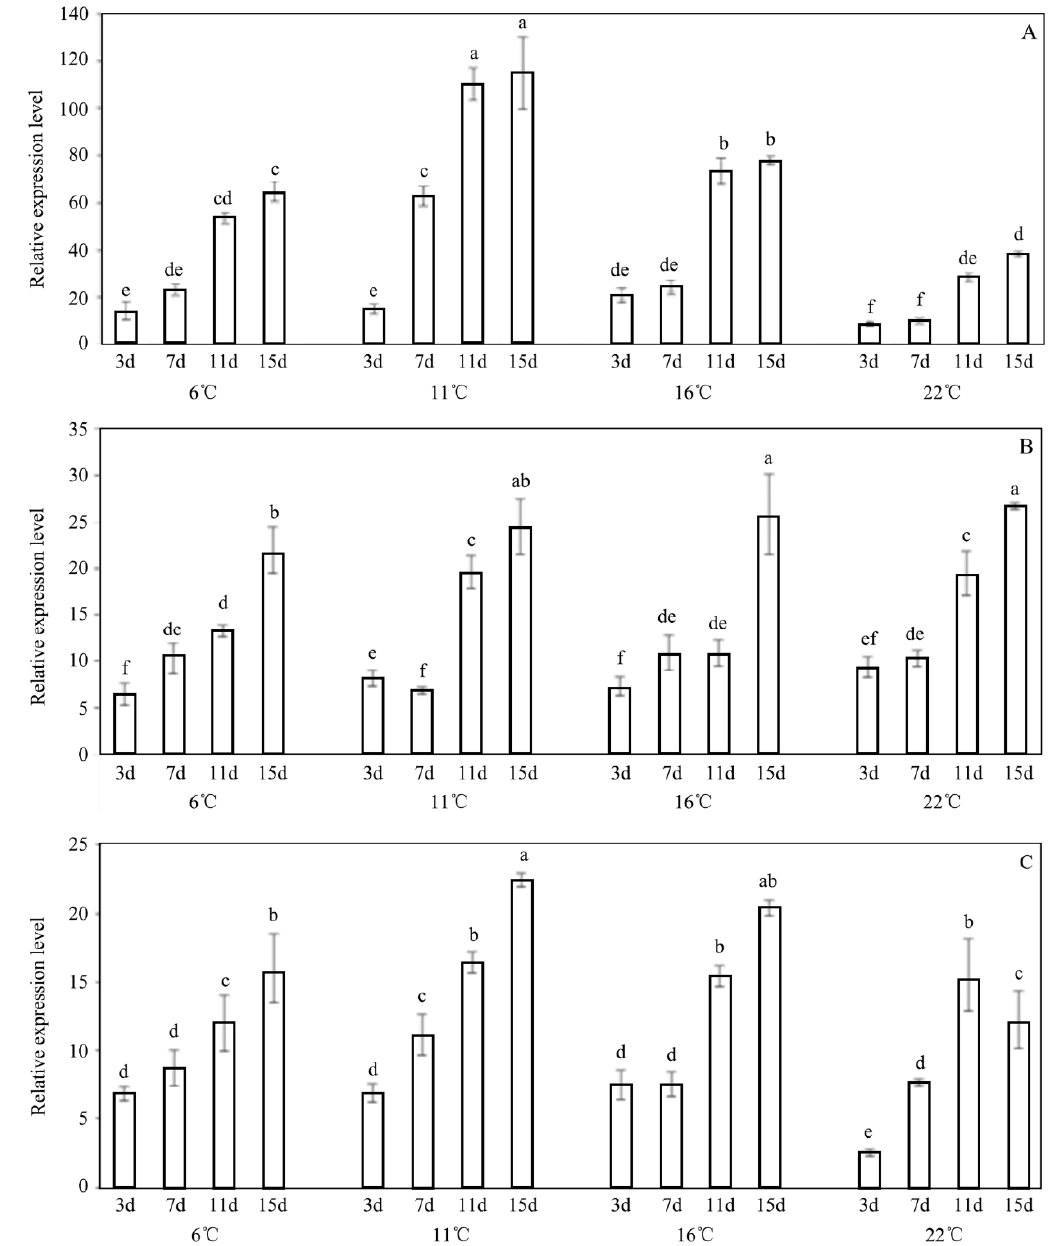
Figure 6. Expression profiles of trehalase genes of E. extimalis after exposure to INA bacteria. ( A ) 0.1 OD; ( B ) 0.2 OD; ( C ) 0.3 OD. Results are shown as the mean ± SD. Letters on the error bars indicate significant differences analyzed using the one-way analysis of variance (ANOVA) with Tukey’s test ( p <